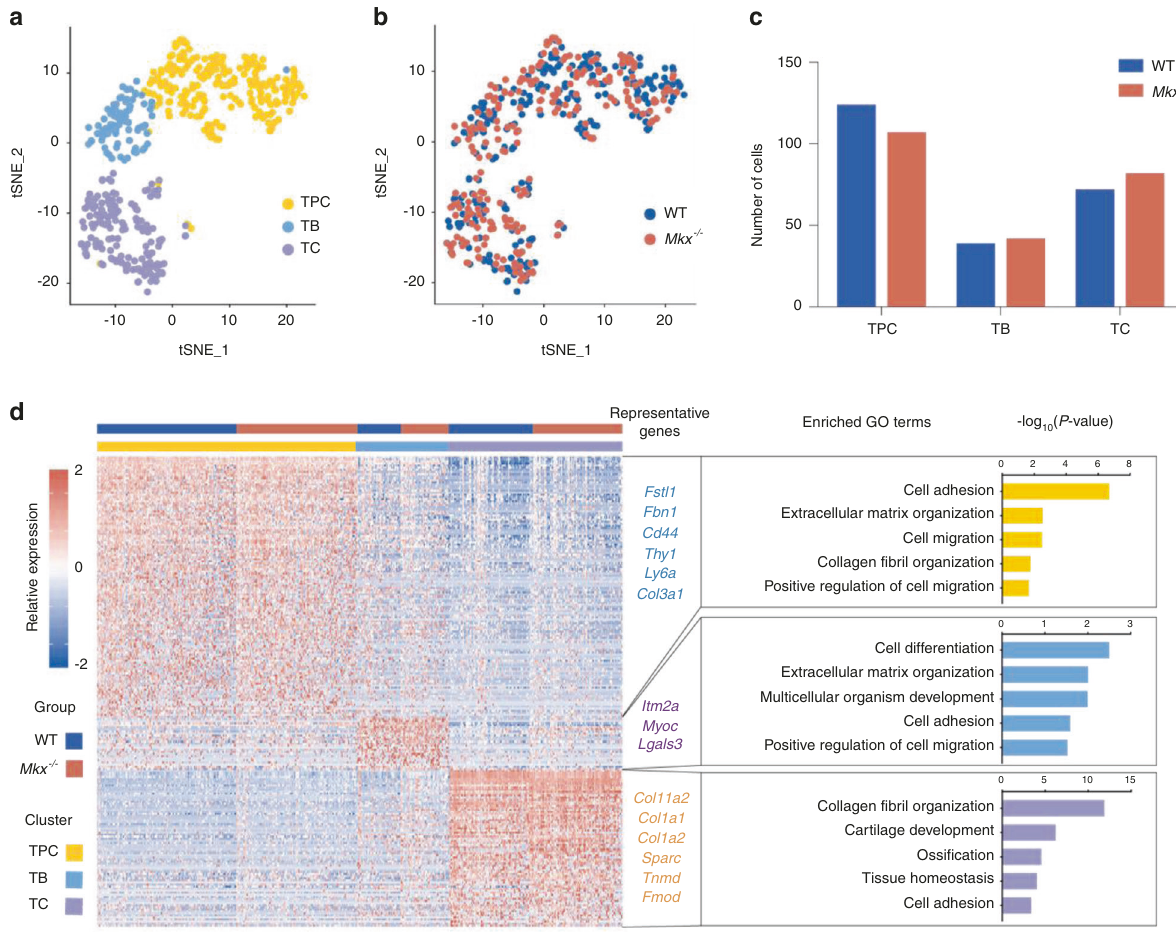
Fig. 3 Single-cell pro fi les of WT and Mkx − / − tendons. a , b t-SNE plot of WT and Mkx − / − tendon cell clusters inferred from scRNA-seq data. The plots were visualized using CC1-CC4 and are colored by cell type ( a ) or genotype ( b ). CC: canonical vectors. c Numbers of WT and Mkx − / − cells in each cell cluster. d Heatmap showing the marker genes for each cell cluster (left) and representative GO terms corresponding to these marker genes (right). TPCs tendon progenitor cells, TBs tenoblasts, TCs